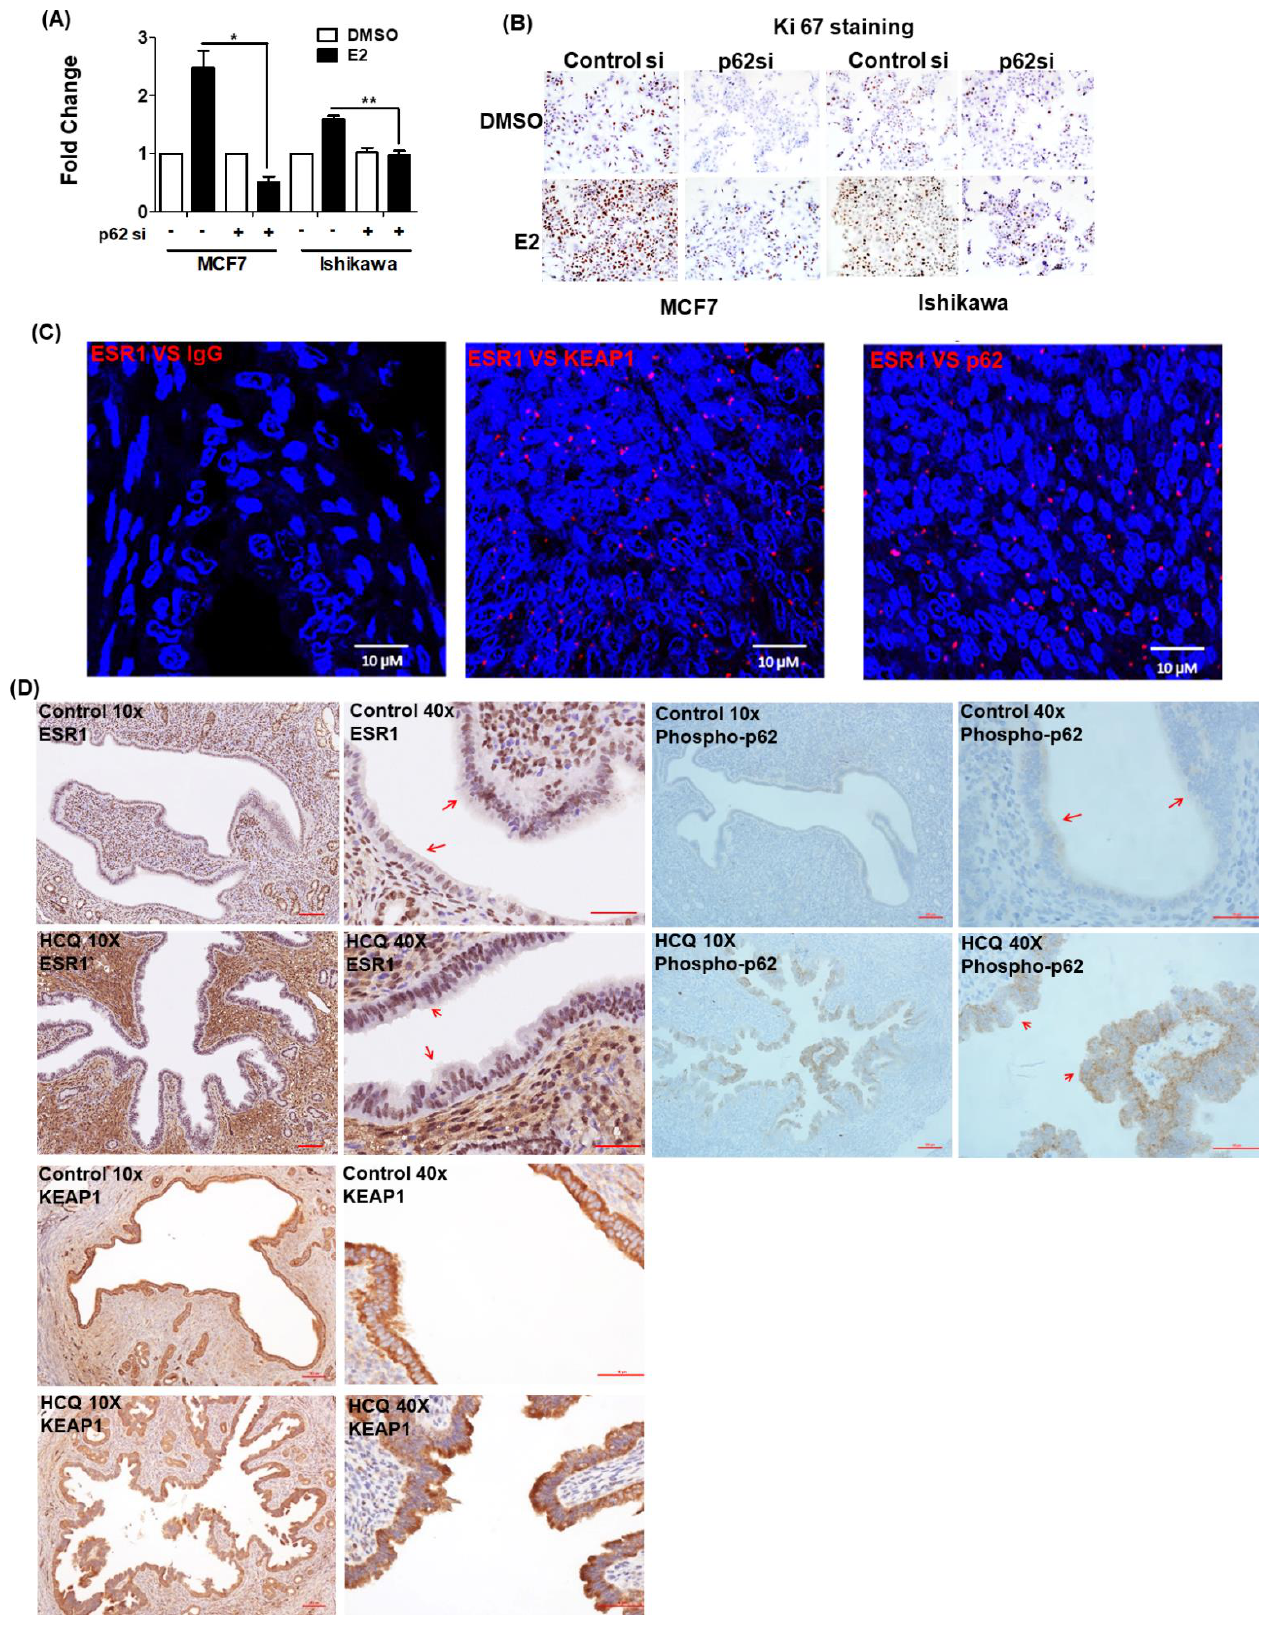
Figure 5. Phosphorylated p62 promotes estrogen receptor α (ESR1) expression. The results of ( A ) the BrdU assay and ( B ) Ki-67 staining revealed that the proliferation capacity of cells with silenced p62 expression was lower than that of control cells. MCF7 and Ishikawa cells were transfected for 48 h with control siRNA or p62 siRNA and subsequently exposed to